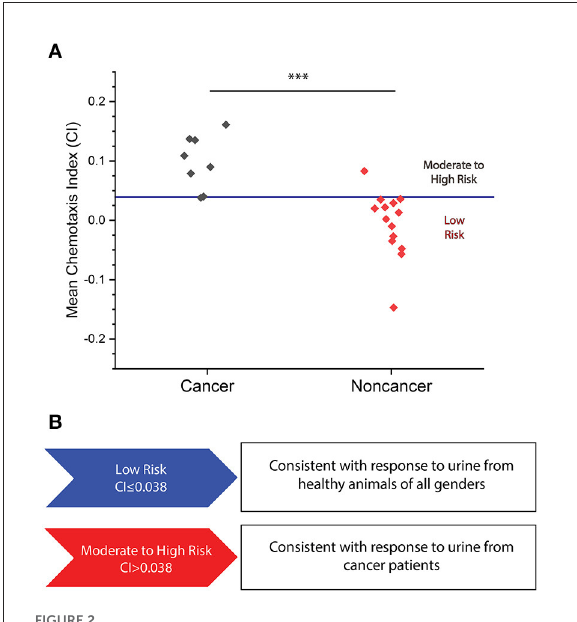
FIGURE2 (A) Mean CI plotted for eight cancer and 14 non-cancer samples for which the N.C.S Study was conducted. A mean CI of 0.099 non-cancer samples ( p to high cancer risk classification threshold. *** p < 0.001.